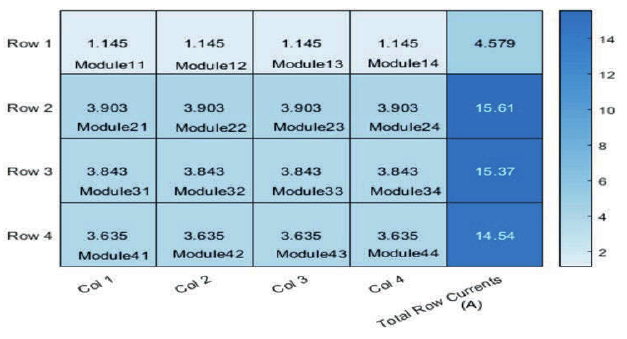
Fig. 6. Initial currents (A) of panels.